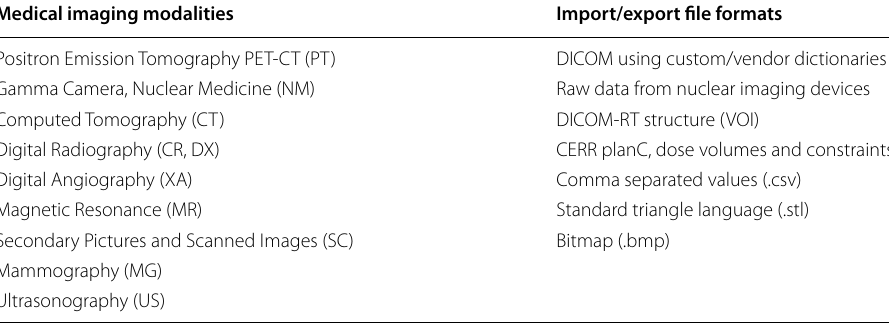
Table 1 TriDFusion image viewer modality and file format compatibility Medical imaging modalities